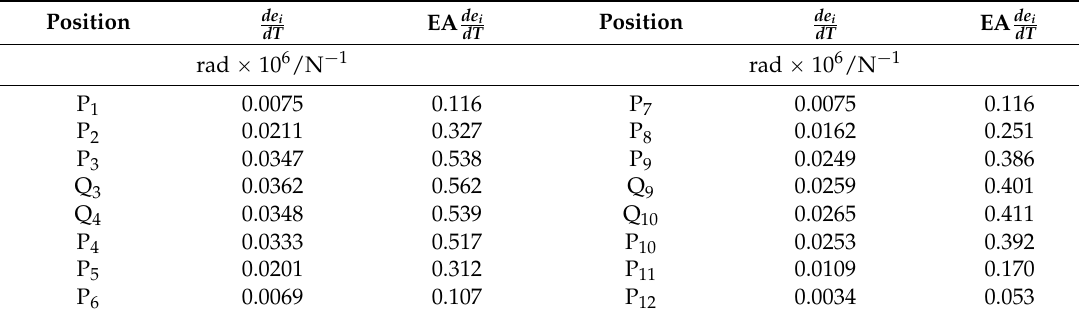
Table 10. Strain and axial force gradients—joint sample